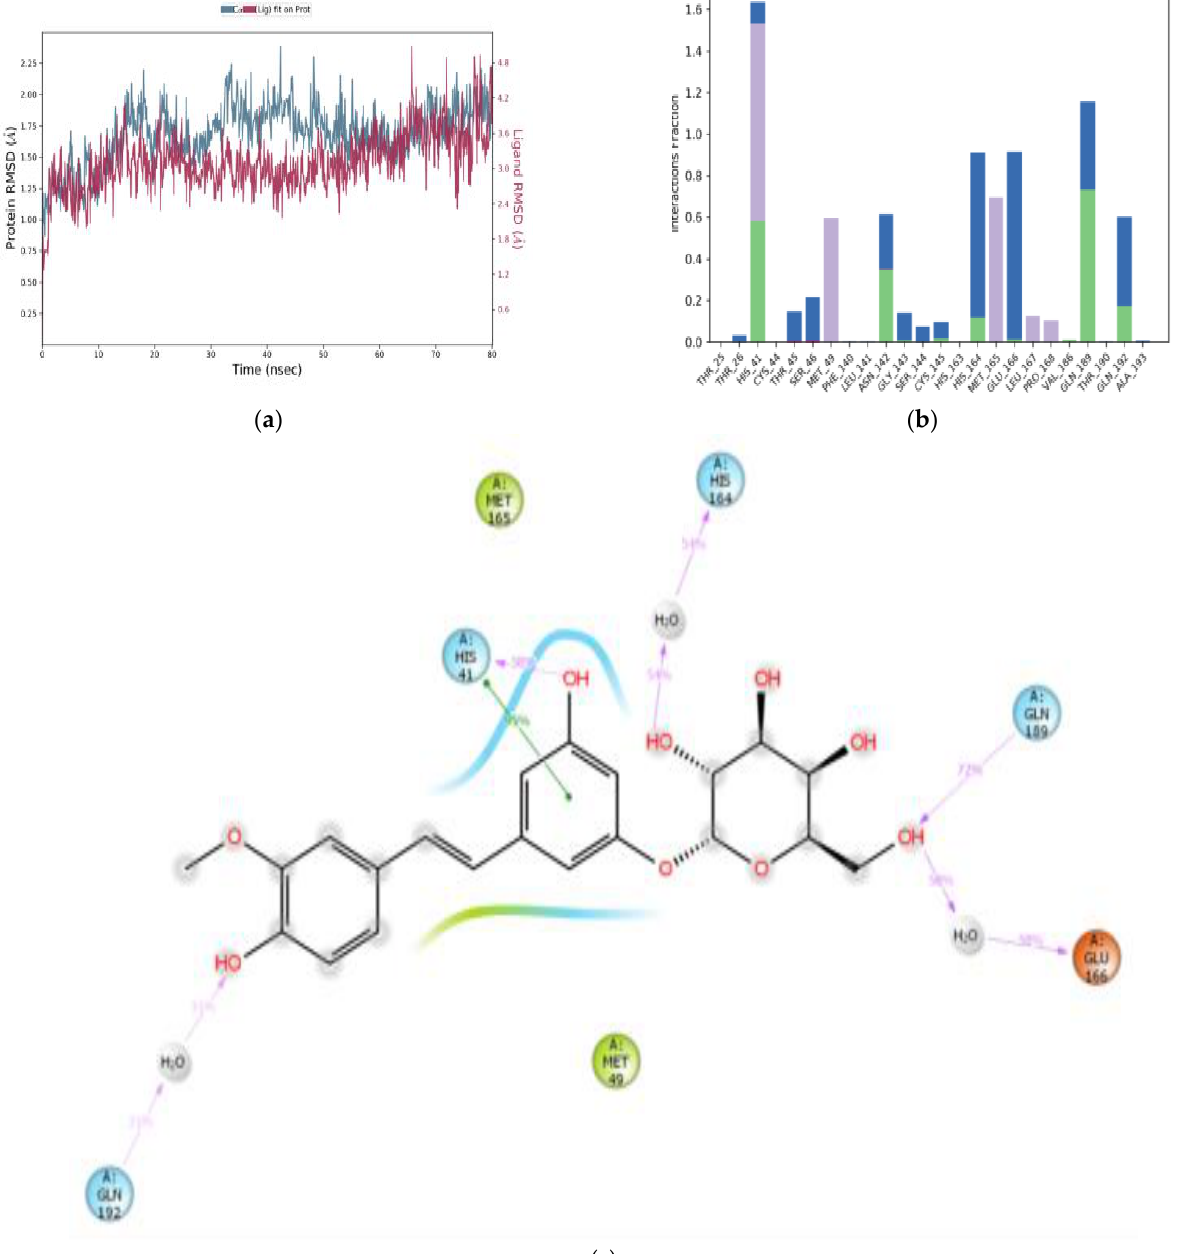
Figure 5. MD simulation studies of astringin (Structure 1) in complex with M pro . RMSD plot of protein backbone (Cα) and protein conformational changes during ligand binding ( a ). Interaction fraction plot showing different protein residues that interact with astringin during a 100 ns MD simulation ( b ). Interaction of ligand atoms with the protein residues that occurs for >60% of the simulation time ( c ).